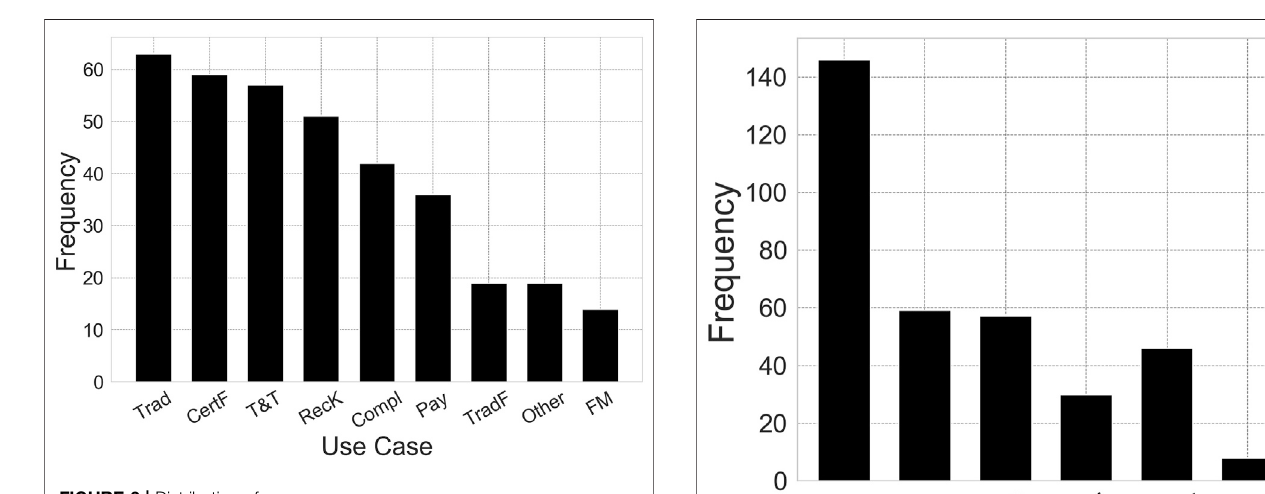
FIGURE 3 | Distribution of use cases.